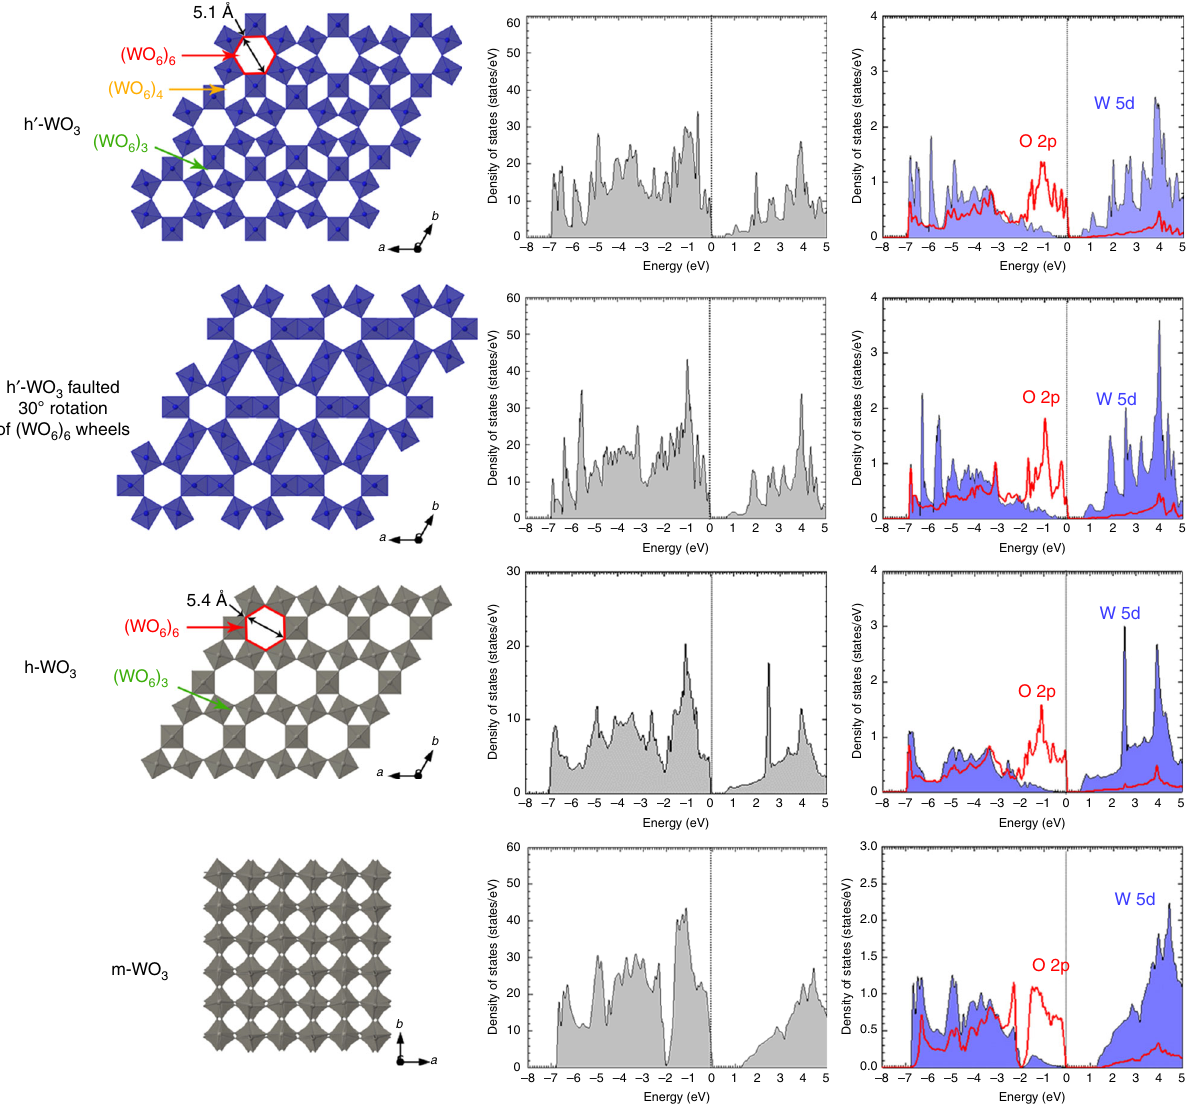
Fig. 4 Electronic structure of h ’ -WO 3 , hexagonal h-WO 3 , and monoclinic m-WO 3 . The 30-(WO 6 ) 6 rotation defects have been taken into account by considering the second phase used for Rietveld re fi nement, where all (WO 6 ) 6 wheels are rotated (rotated h'). For hexagonal phases, the diameter of the (WO 6 ) 6 channels is speci fi ed from oxygen ion centers. After subtraction of oxygen radii, the internal channel diameters are ca. 4.8 and 5.1 Å for h ’ -WO 3 and h-WO 3 , respectively. The calculated total densities of states (DOS) are shown for each